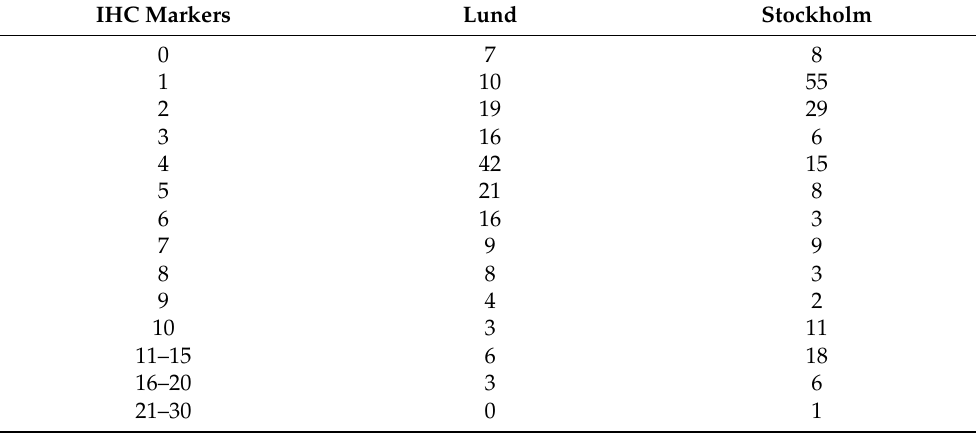
Table 3. Number of diagnostic immunohistochemical (IHC) markers for the 164 (Lund) and 174 (Stockholm) pre-surgical samples with diagnosis. IHC Markers